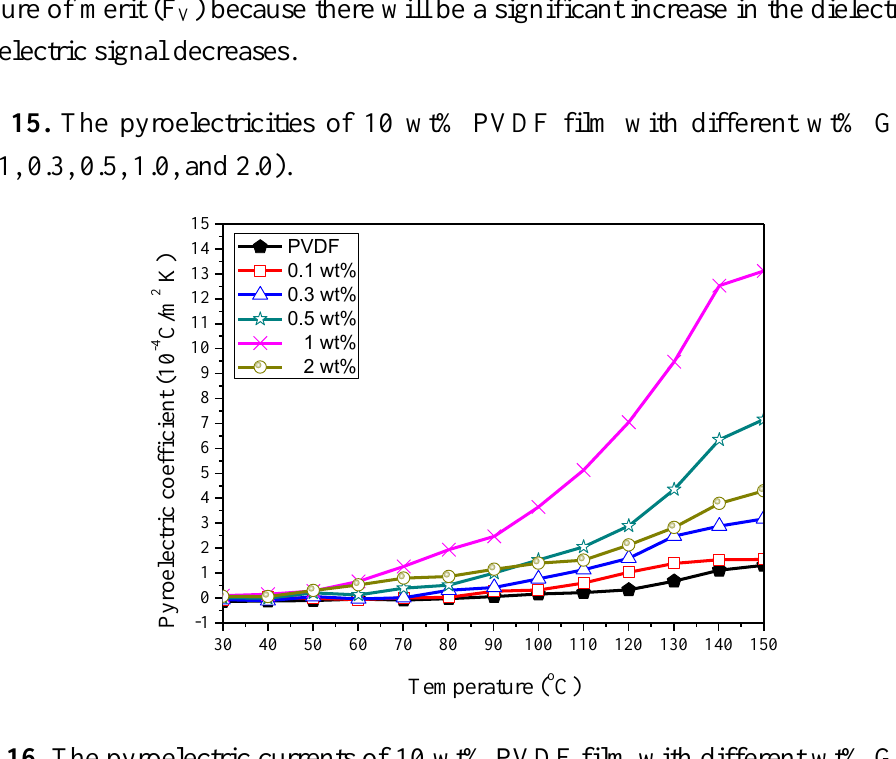
Figure 16. The pyroelectric currents of 10 wt% PVDF film with different wt% GO-doping (0.0, 0.1, 0.3, 0.5, 1.0, and